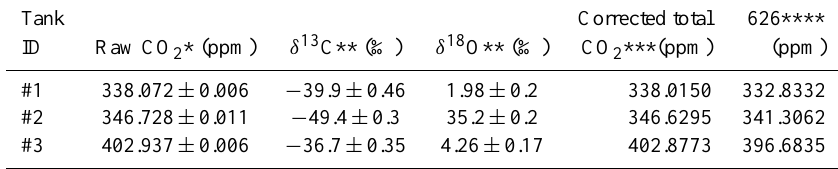
Table 1. Calibration tank CO 2 information. Errors are 1 standard deviation from repeated measurements.